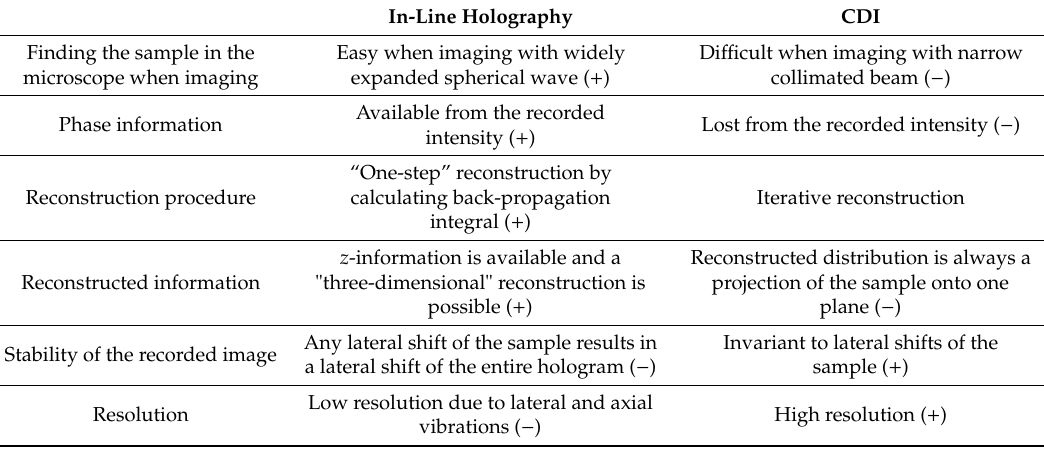
Figure 27. Schematic of ( a ) in-line holography and ( b ) coherent di ff raction imaging (CDI). Table 1. Advantages and disadvantages of in-line holography (defocus imaging) and